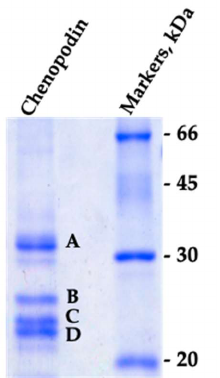
Figure 1. The SDS-PAGE showing the polypeptide composition of the purified chenopodin. The gel was run under reducing conditions. Letters indicate the bands analyzed by mass spectrometry for identification.